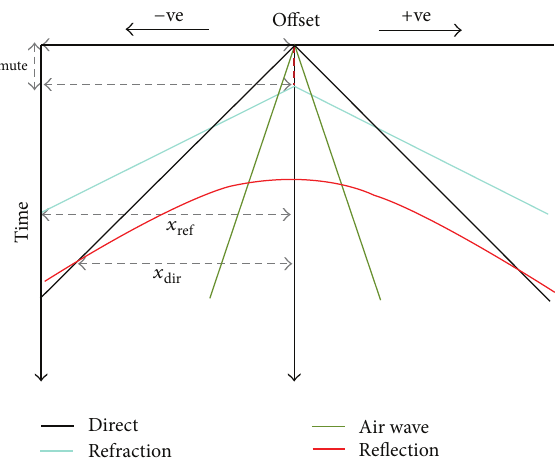
Figure 3: Seismic preprocessing